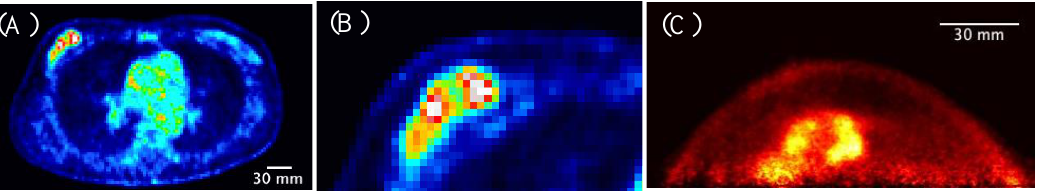
Figure 14. Side-by-side comparison of 307 MBq PET images from a breast cancer patient scanned with a Siemens Biograph PET/CT reconstructed using a time-of-flight reconstruction technique (TOF) ( A , B ) and with the Radialis PET system ( C ).